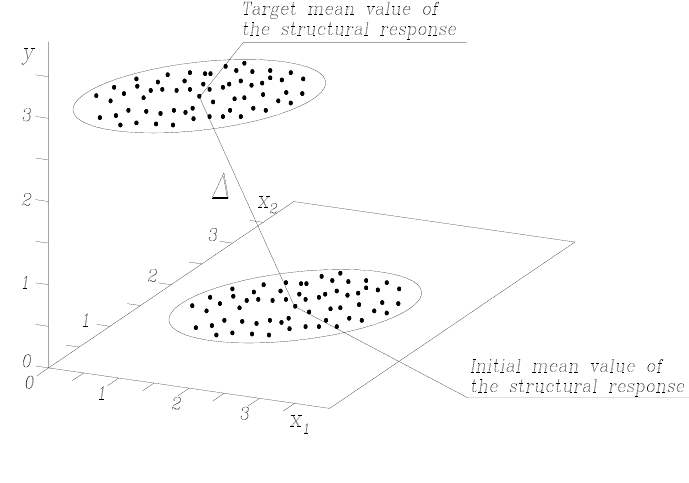
Figure 2: initial and final structural responses.